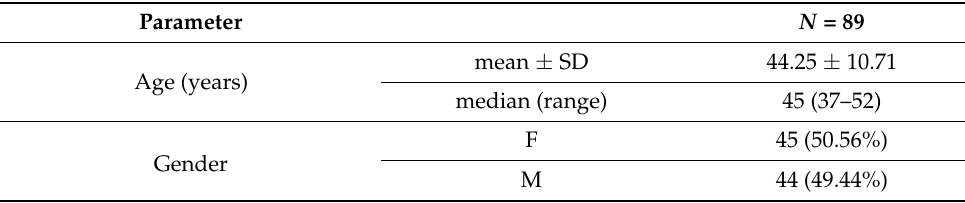
Table 1. The descriptive statistics of the study